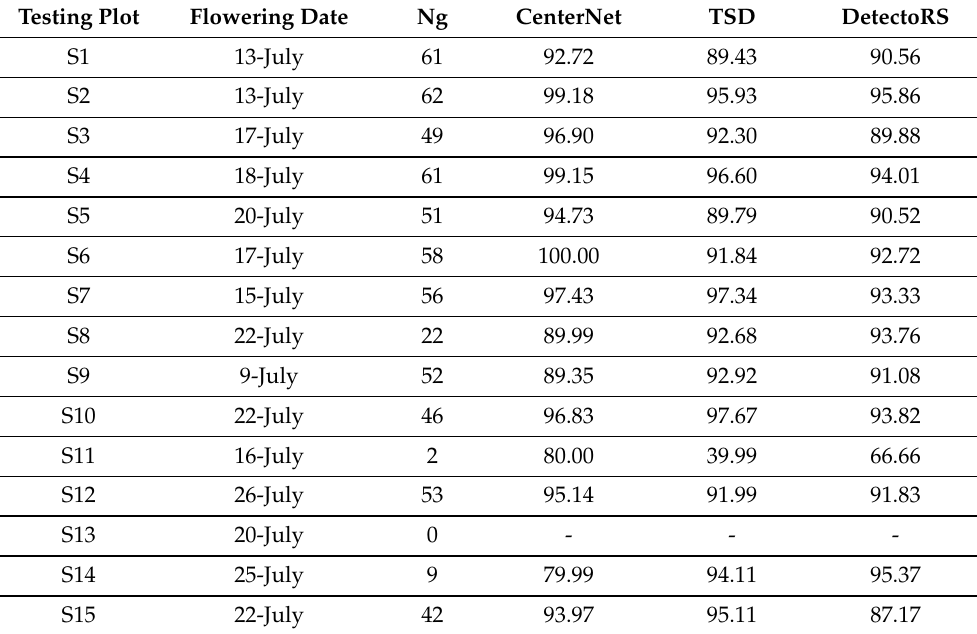
Table 5. Testing results for detection-based metrics for individual plots. Testing